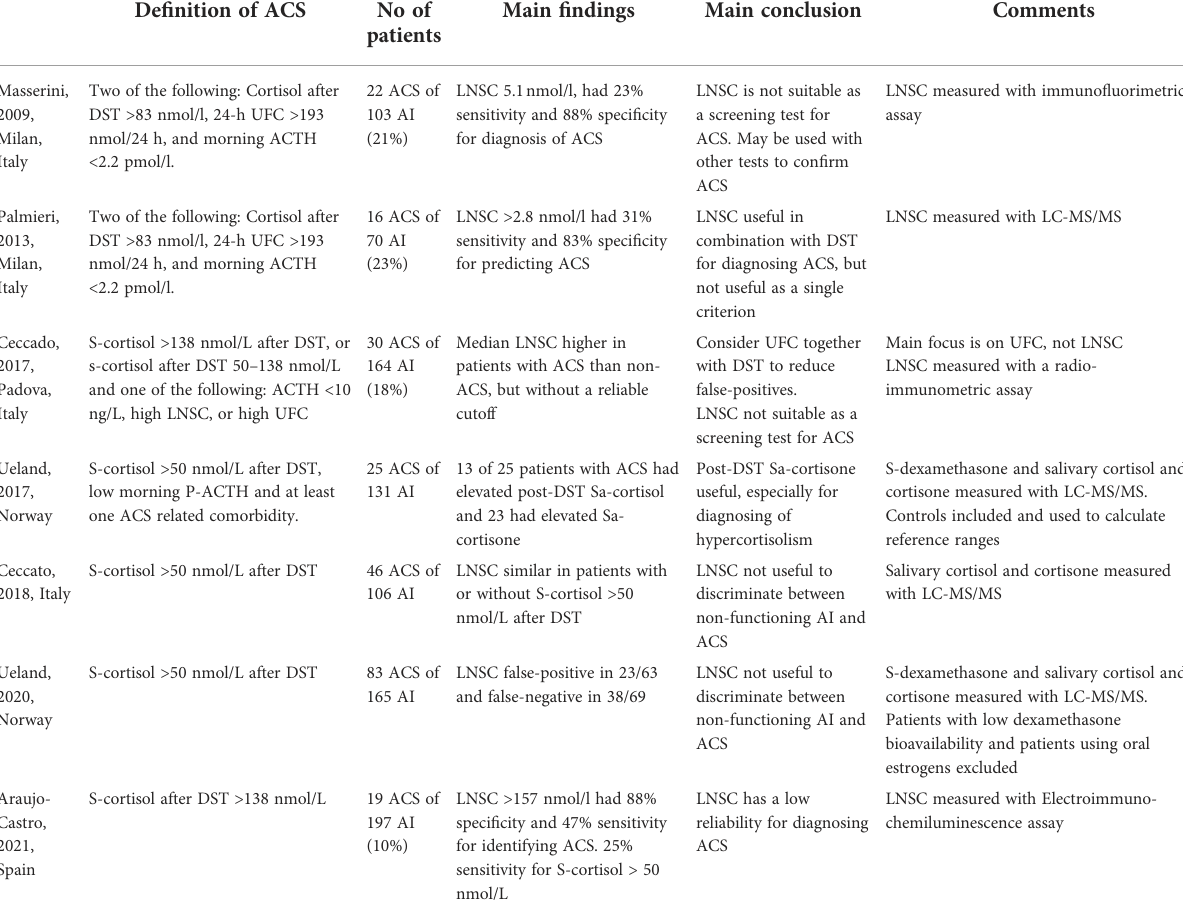
TABLE 5 Summary of studies that have evaluated the diagnostic value of salivary cortisol in patients with adrenal